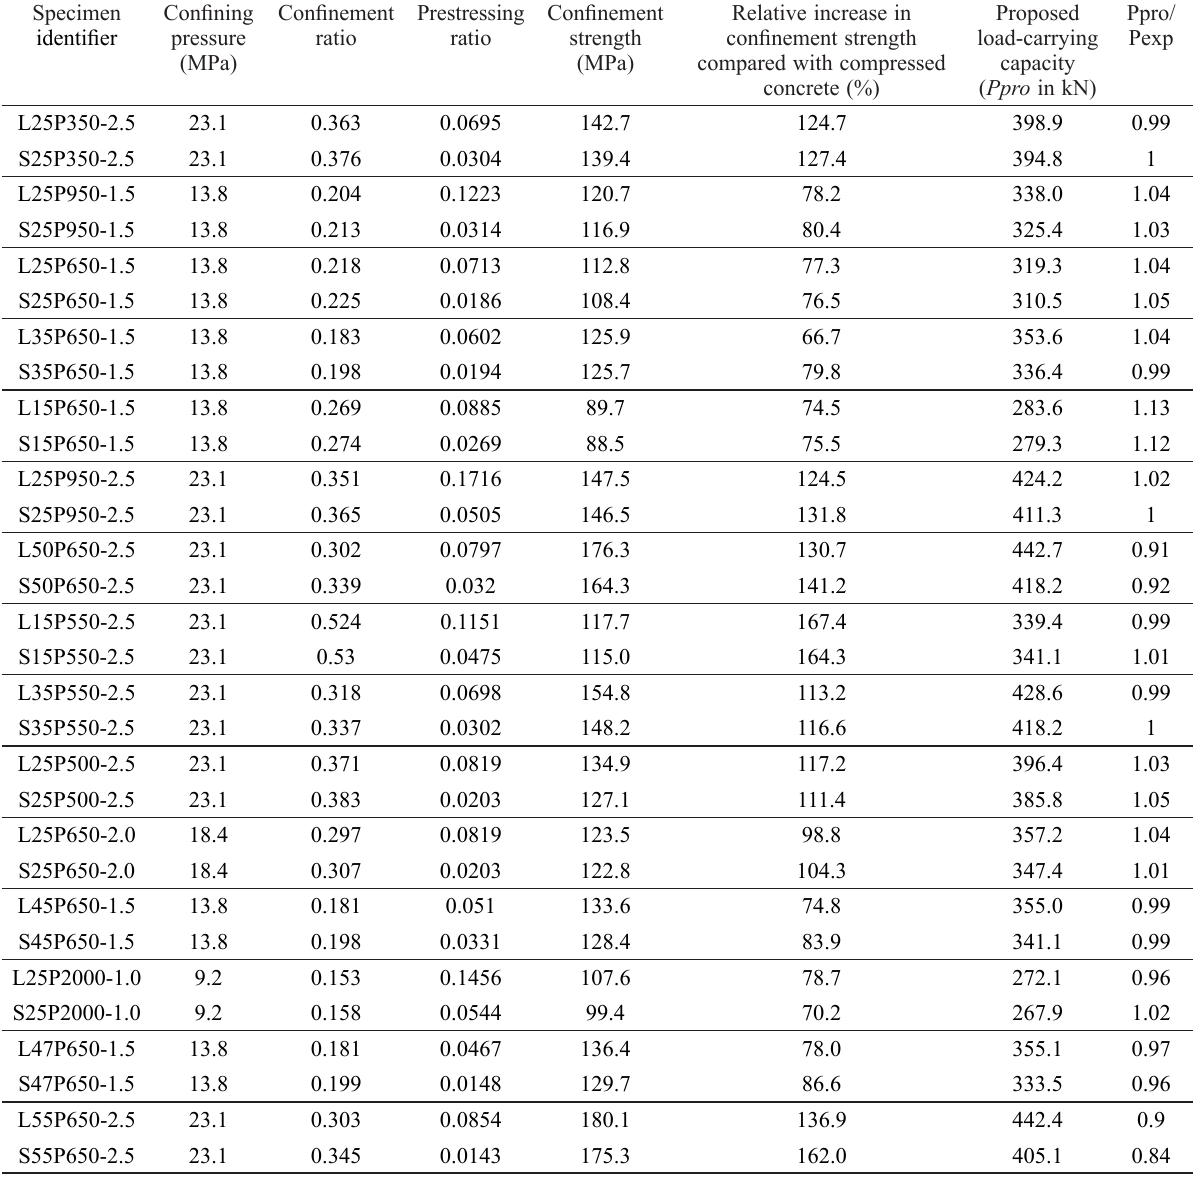
Table 5. Confinement strength and load-carrying capacity results of actively-confined